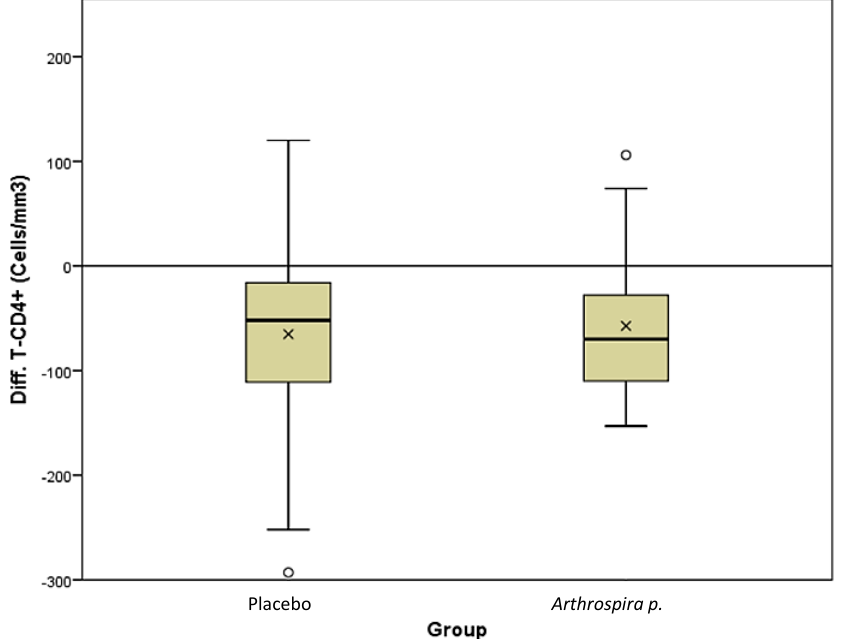
Figure 1. The difference (Diff) of the CD4 lymphocyte counts between the groups receiving placebo and A. platensis at the end of the study. The box plot represents the median and the IQR. The zero line represents no change. The crosses indicate the